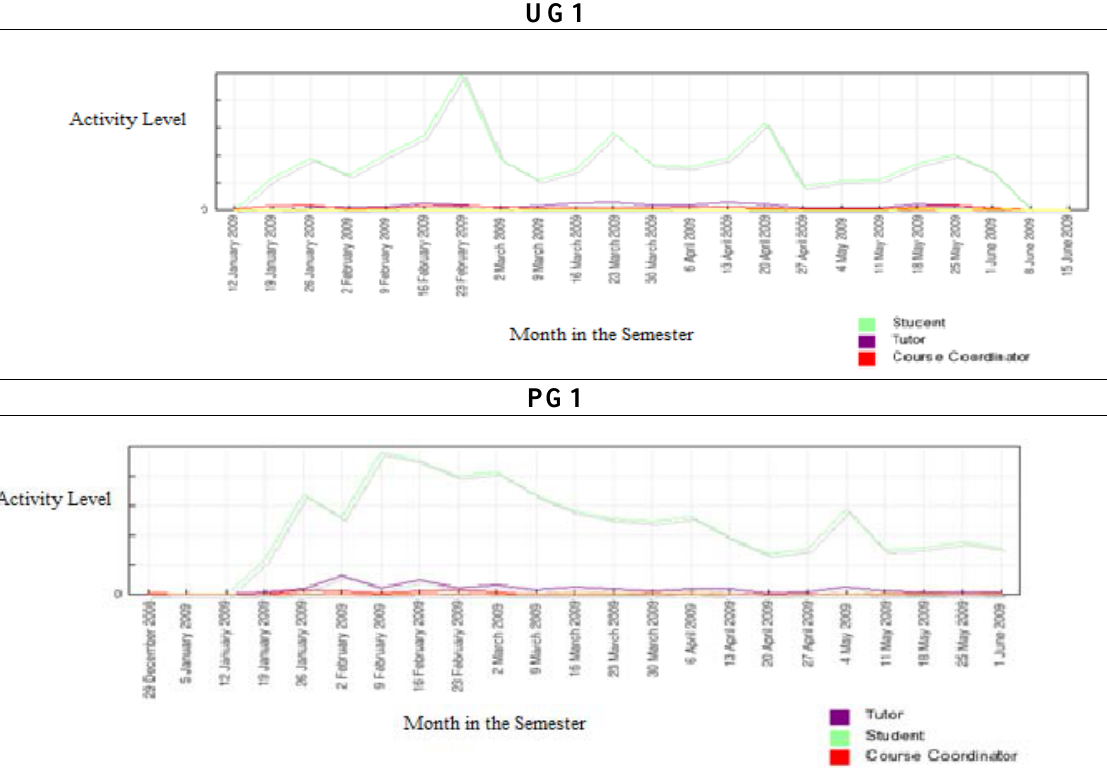
Figure 2: Pattern of Access/Activity in the LMS of UG1 and